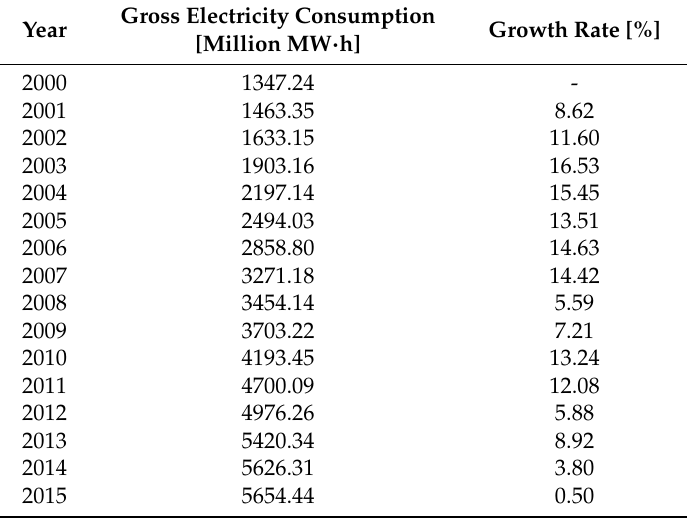
Table 1. Annual electricity consumption of China in 2000–2015.